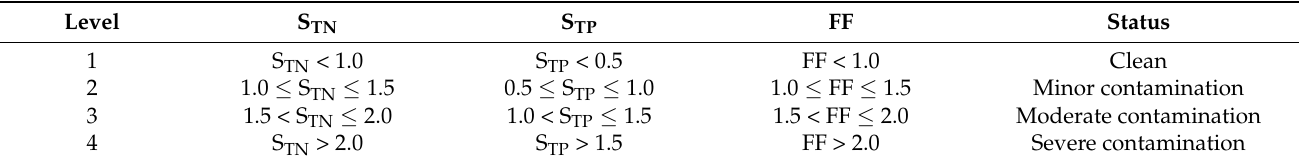
Table 1. Standard and grades of comprehensive pollution in